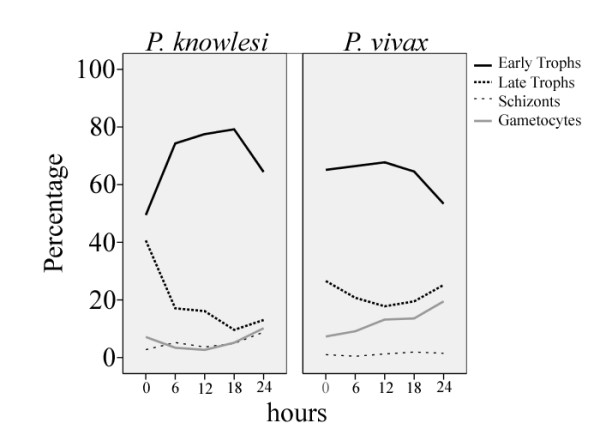
Change in mean parasite stage distribution during the first 24 hours of treatment with oral chloroquine.